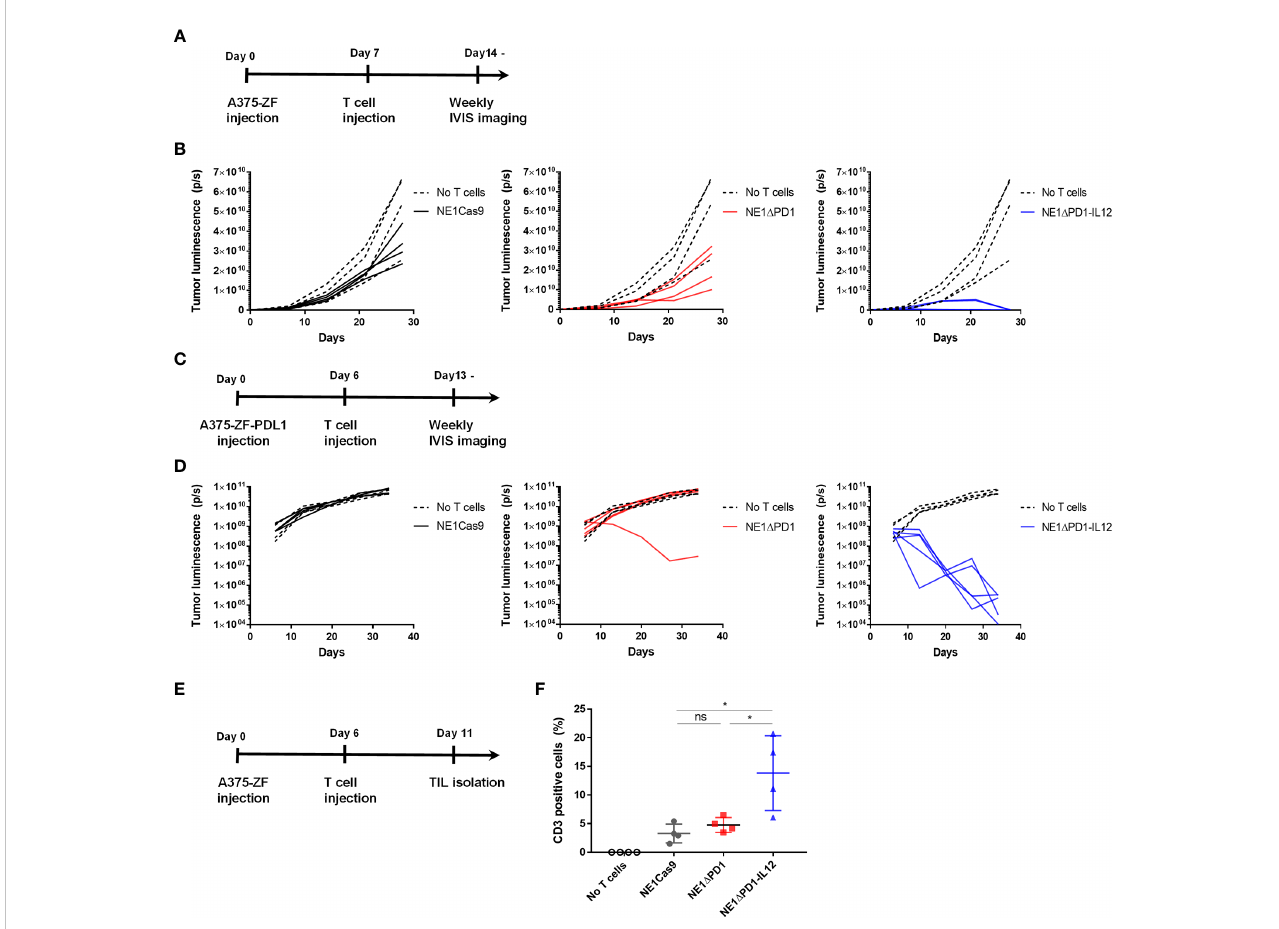
FIGURE 5 Enhanced anti-tumor activity of D PD-1-IL-12-edited NY-ESO-1 TCR-T cells in vivo (A) Timeline for in vivo experiment performed with A375-ZF tumor cells. Immunode fi cient NSG mice were subcutaneously injected with 1 × 10 6 A375-ZF cells. After 7 days, 1 × 10 6 NY-ESO-1+ T cells were intravenously injected. The luminescence signal from tumor cells was measured weakly using an in vivo imaging system (IVIS). (B) Quantitative analysis of bioluminescent signal from individual mouse. D PD-1-IL-12 T cells exhibited superior anti-tumor activity (n = 4 mice per group). (C) Timeline for in vivo experiments performed using the PD-L1-overexpressed A375 model. Six days after subcutaneous injection of A375-ZF-PDL1 cells, 1 × 10 6 NY-ESO-1 + T cells were intravenously injected. The luminescence signal from tumor cells was measured weekly using IVIS. (D) Quantitative analysis of bioluminescent signal from individual mouse. Tumors were cleared in only one of the PD-1 deleted NY-SO-1-treated mice. All NE1 D PD-1-IL-12-treated mice were cured from tumors (n = 4 mice for no T cells and NE1Cas9, n = 5 mice for NE1 D PD-1 and NE1 D PD-1-IL-12). (E) Timeline for investigating engineered T cells in fi ltrated into the tumor site. A375-PDL1 tumor cells and NY-ESO-1 speci fi c T cells were injected as in (C) At 11 d, the mice were sacri fi ced and tumors were harvested. Tumors were mechanically dissociated and the in fi ltrated T cells were analyzed by fl ow cytometry. (F) The percentage of CD3+ cells in tumor tissues (n = 4 mice per group). Data are presented as mean ± SEM. The P -value was determined by two-tailed unpaired t -test. *P<0.05 was considered statistically signi fi cant. ns, not signi fi